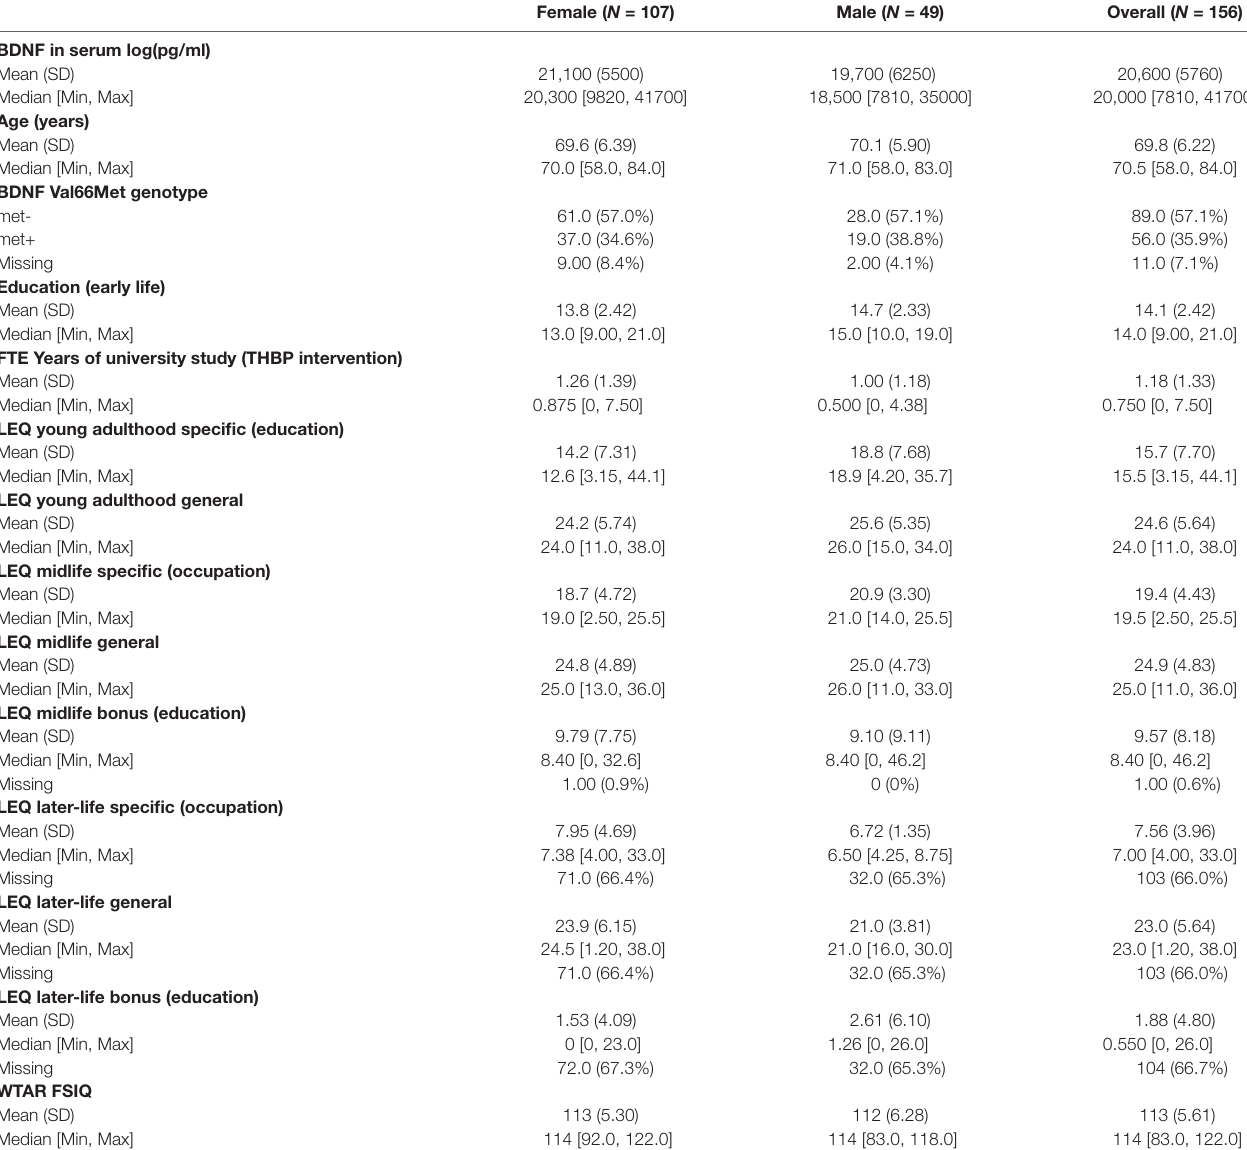
TABLE 1 | Characteristics of all included THBP participants ( n =